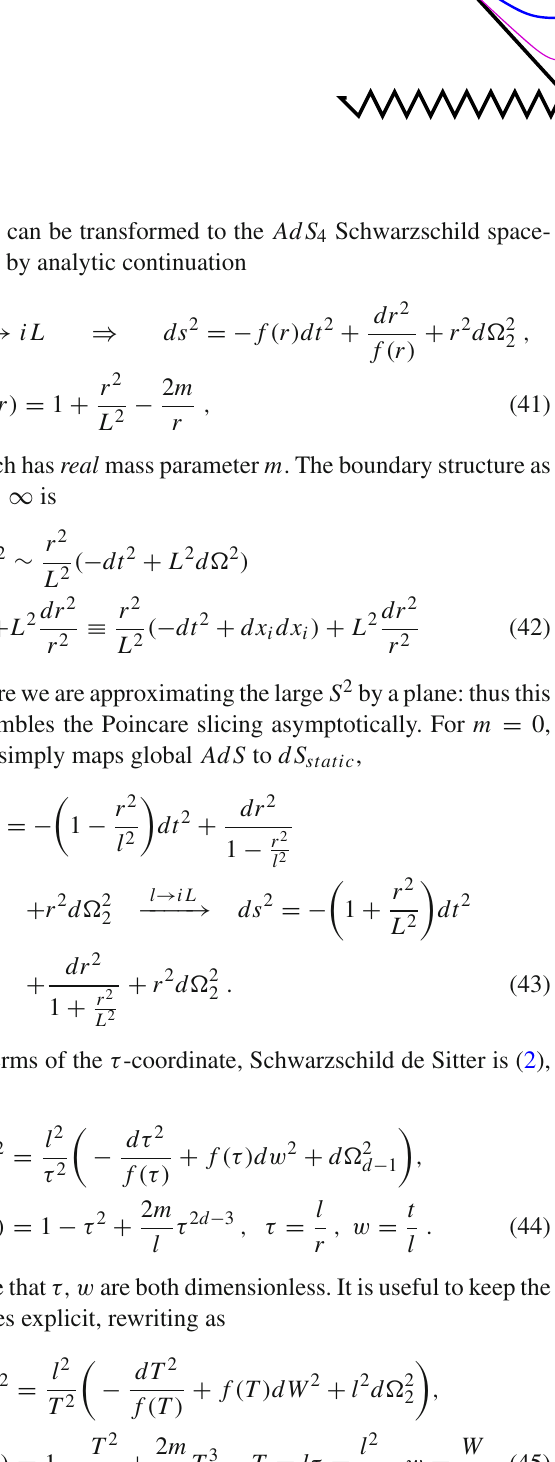
Fig. 4 Extremal surfaces in the (τ,w) -plane in the Nariai limit of Schw dS : the blue curve is for generic A , while the A → 0 limit gives the purple